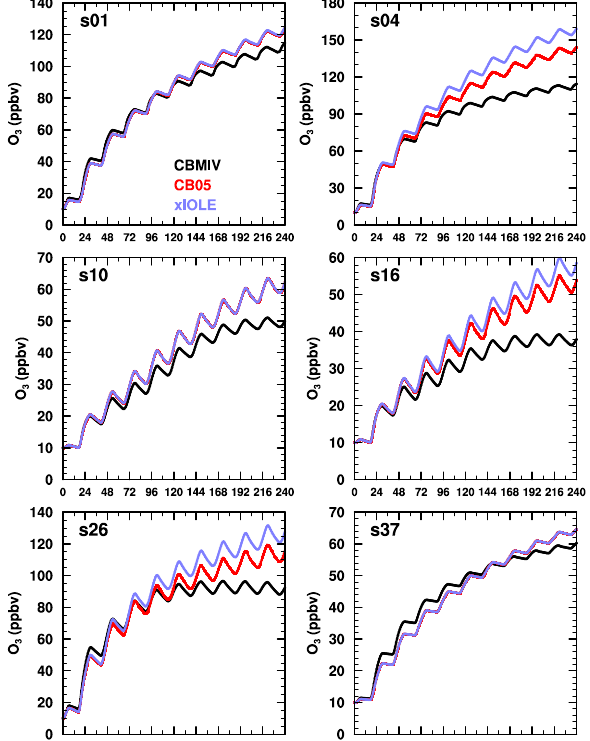
Fig. 6. Example scenario results for sensitivity test xTERP. Ozone mixing ratios (ppbv) for the base CB05 (red), base CBMIV (black) Figure 6 . Example scenario results for sensitivity test xTERP . Ozone mixing ratios (ppbv) 4 for the base CB05 (red), base CBMIV (black) and sensitivity test xTERP (violet) over the 240 5 and sensitivity test xTERP (violet) over the 240h simulation hr simulation period. 6 7